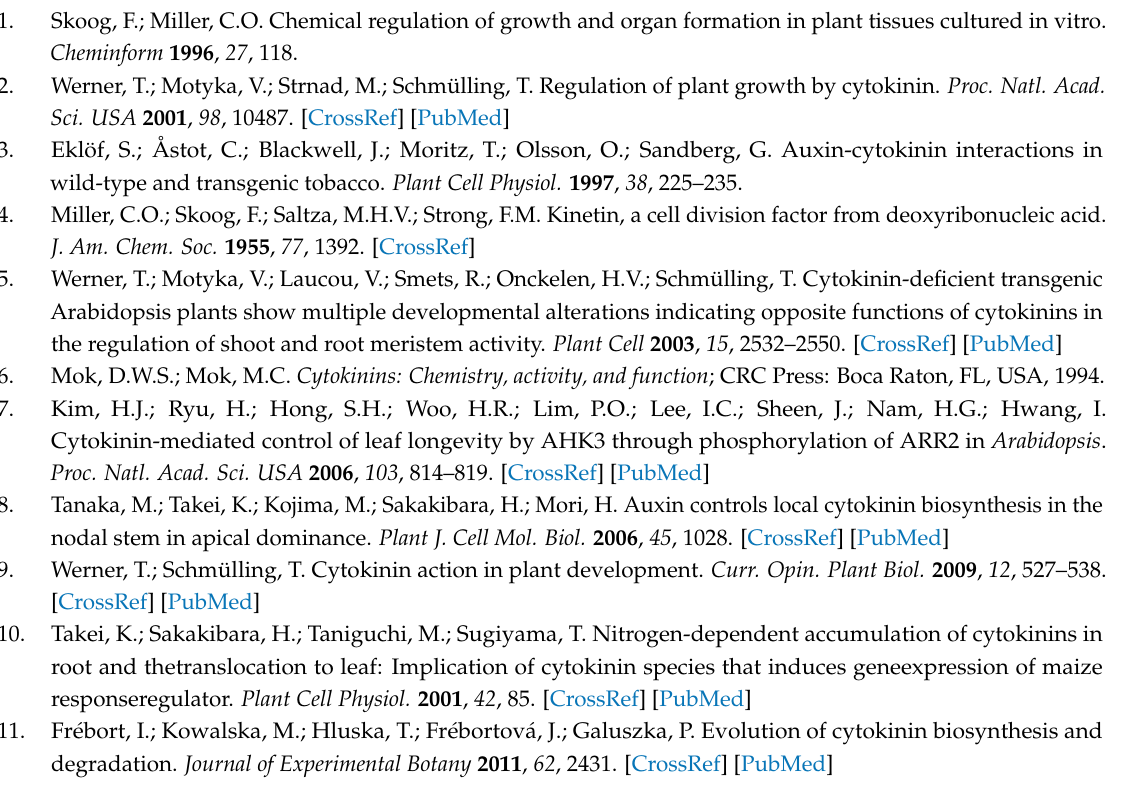
Table S1: Silique length of extremely materials at several stages of pod development, Table S2: Primers used for quantitative reverse-transcription polymerase chain reaction (qRT-PCR) analysis of BnCKX genes, Table S3: Stress- and hormone-responsive elements in the promoter regions of BnCKX genes, Table S4: The expression levels differences of selected four genes by variance analysis, Table S5: RNA-Seq data of 23 BnCKX